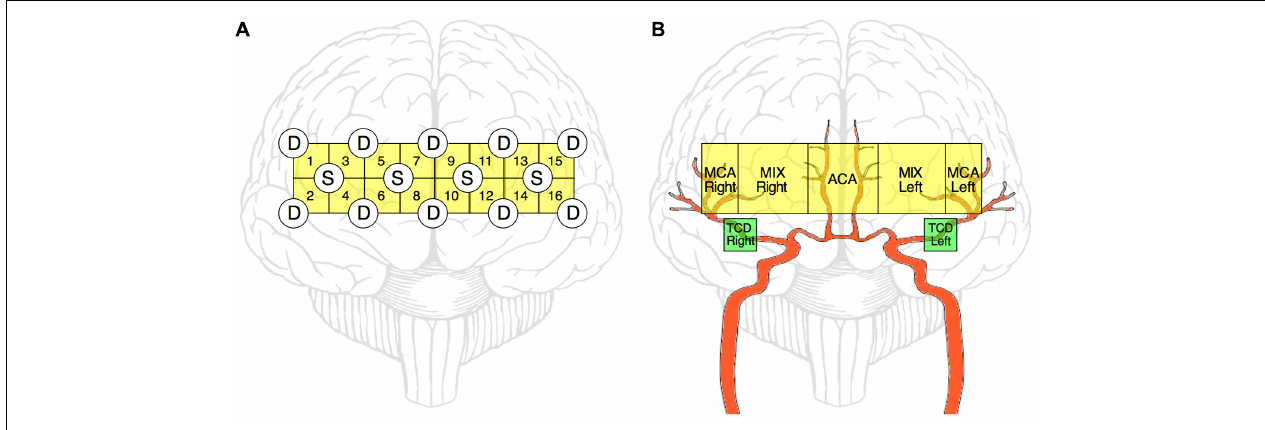
FIGURE 1 | Schematic representation of NIRS and TCD measurements. NIRS-optode layout over the prefrontal cortex (A) . Four light-emitting diode sources (S) and ten photodetectors (D) are arranged in a square array forming 16 channels altogether. Of these 16 channels, ultimately 5 regions of interests are defined (by averaging the obtained relationship parameters within that region) to reflect the features of blood supply in the prefrontal cortex ( B , yellow blocks). The main relevant arterial supply routes are shown in red. MCA Right, right middle cerebral artery; MCA Left, left middle cerebral artery; ACA, anterior cerebral artery; MIX Right, region supplied by MCA Right and ACA; MIX Left, region supplied by MCA Left and ACA; TCD Right and Left, sites of transcranial Doppler sonography measurement ( B , green